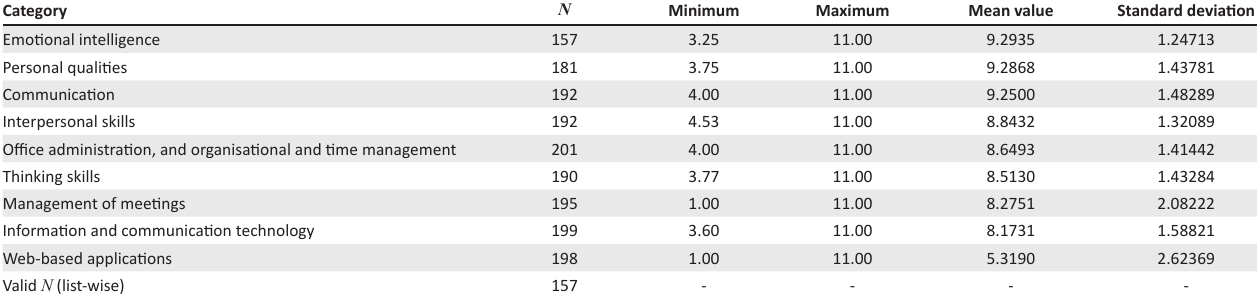
TABLE 4: Summary of the mean values of all categories.